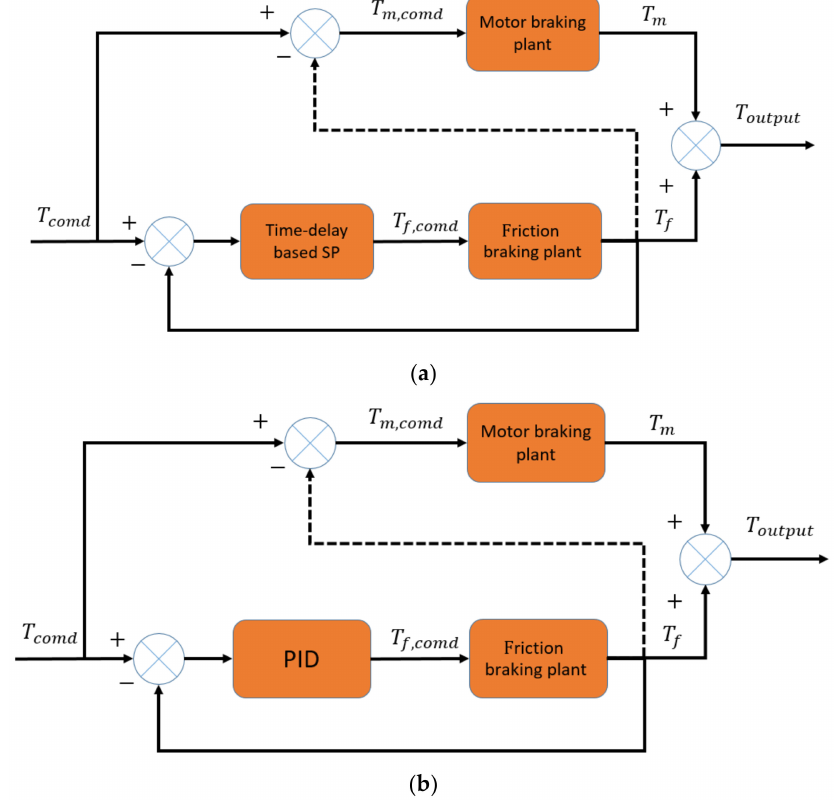
Figure 9. ( a ) Time-delay-based SP for braking torque tracking. ( b ) PID for braking torque